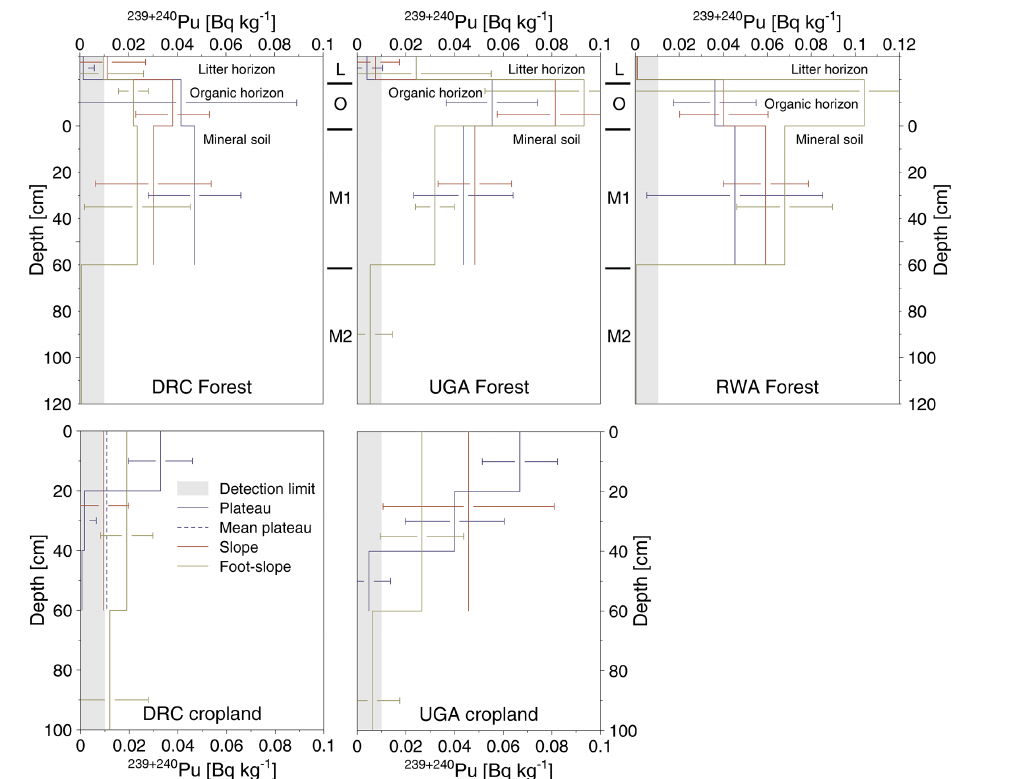
Figure 3. Catenae-related depth profiles of 239 + 240 Pu activity and standard deviations (whisker) within three pristine forests (DRC: DR Congo, UGA: Uganda, RWA: Rwanda) and two cropland study sites. Please note that the L and O horizons are for illustrative purposes shown thicker than they naturally